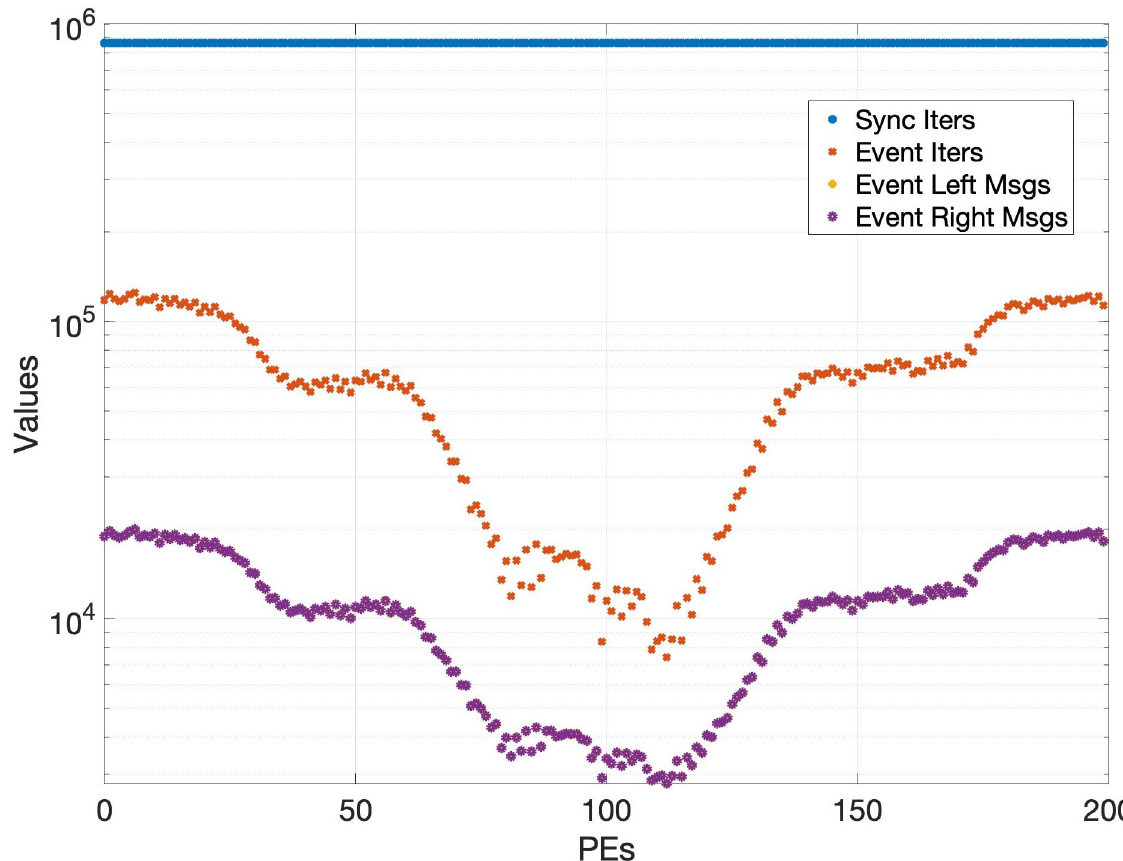
Fig 9. Plot highlighting the number of messages sent by each of the 200 PEs to the left and right neighbors with the event-triggered communication algorithm considering horizon h = 750 and decay d = 0.8. The number of iterations with the synchronous solver (Sync Iters in the plot legend) which is the same for all PEs is shown by the blue line for reference. In contrast, the number of iterations taken by each of the PEs in the event-triggered solver (Event Iters in the plot legend) is shown by the red asterisks. Further, the number of messages sent to the left neighbor and right neighbor (shown as Event Left Msgs and Event Right Msgs in the plot legend) by each of the PEs is shown respectively by the yellow star sign and the purple round sign. The number of messages for both the left and right neighbors for every PE are quite close. Hence the purple round signs overlap the corresponding yellow star signs for all the PEs. It is seen that the number of messages is considerably lesser than the number of iterations for any PE, thus illustrating the benefit of reduced messages in event-triggered